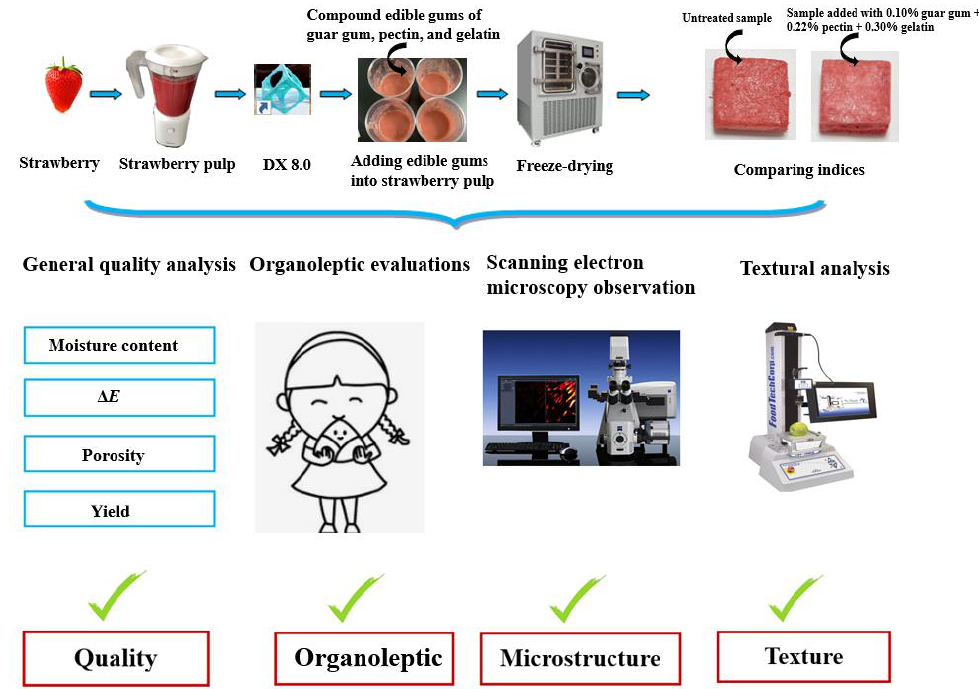
Figure 6. Schematic overview of the experimental procedure.